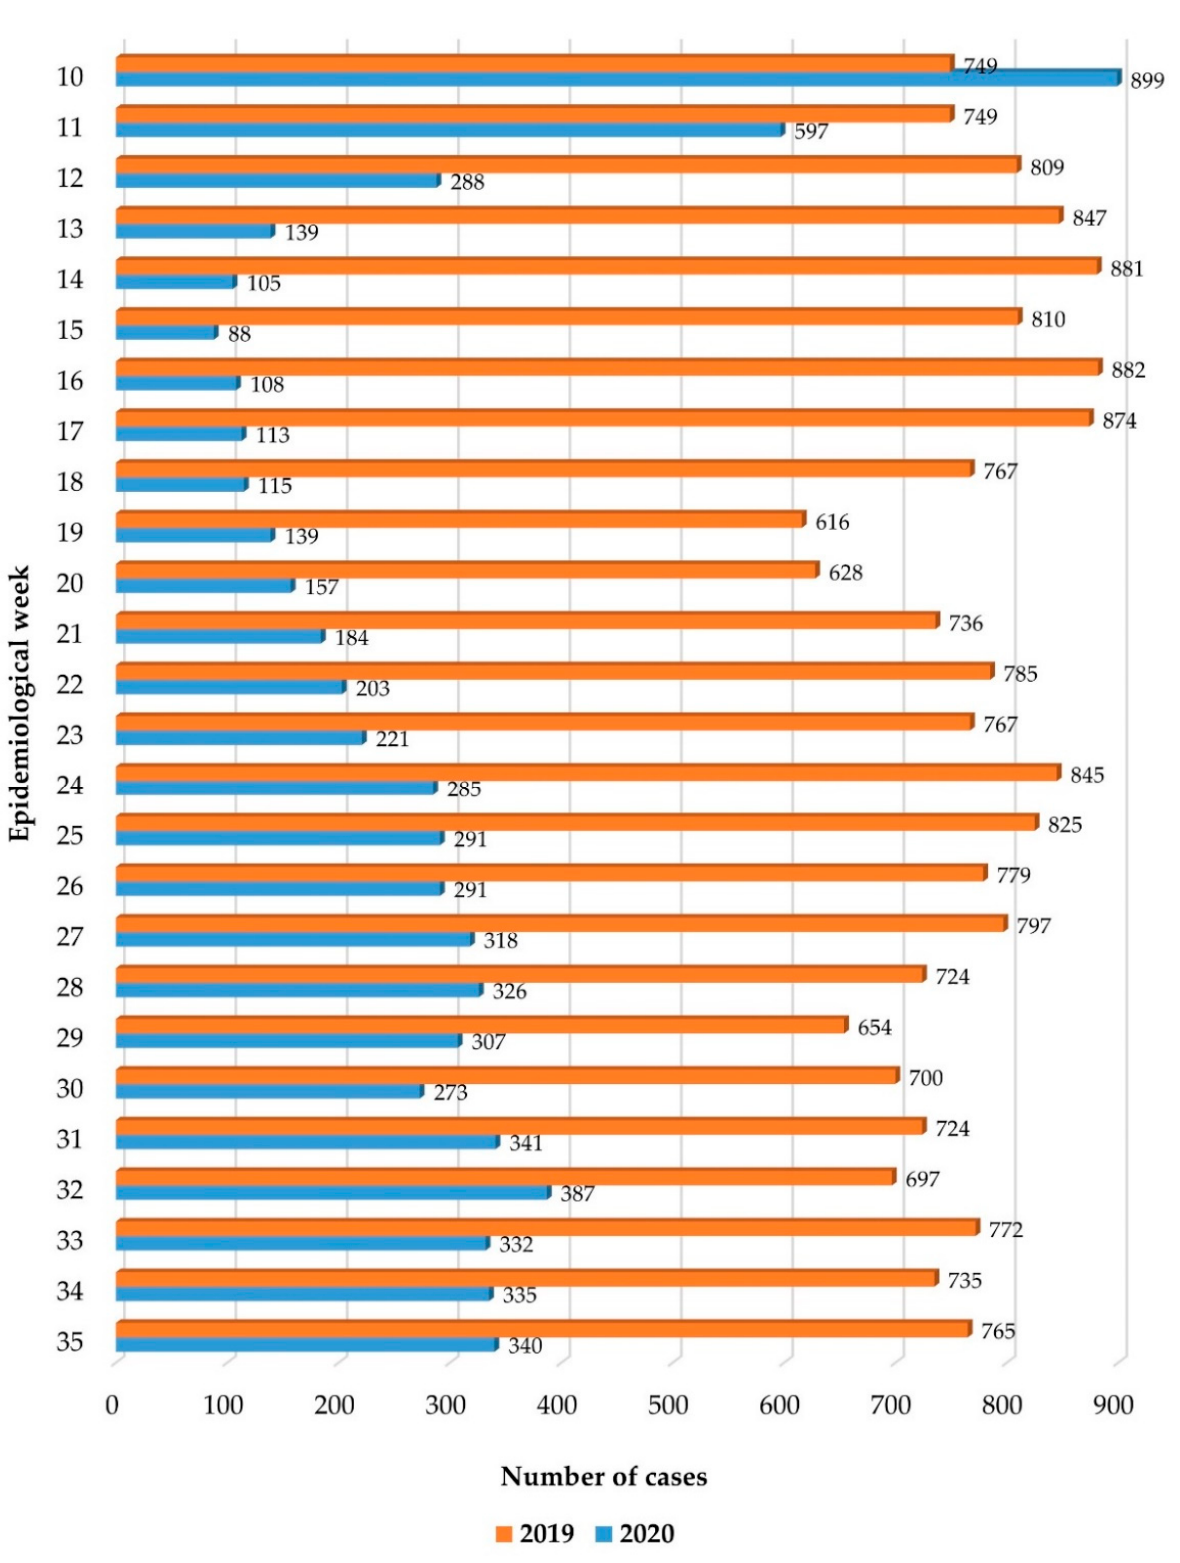
Figure 1. Distribution of pediatric cases presented to the emergency department by epidemiological weeks (2019 vs. 2020).